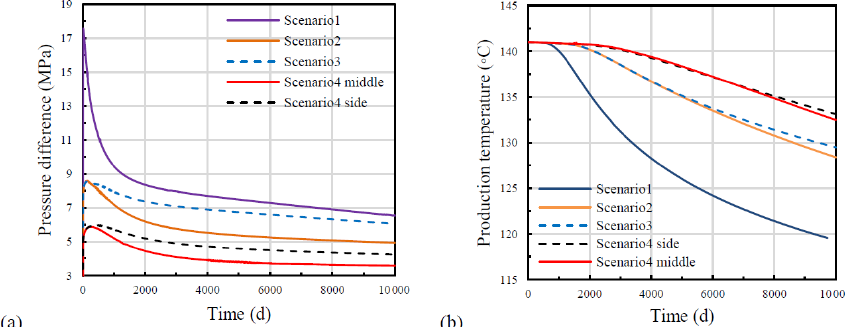
Figure 9. (a) Pressure evolution over time and (b) Temperature evolution over time for the four modelling scenarios (the middle and side for scenario 4 indicate the fracture zones located in the middle part and the side parts, respectively).